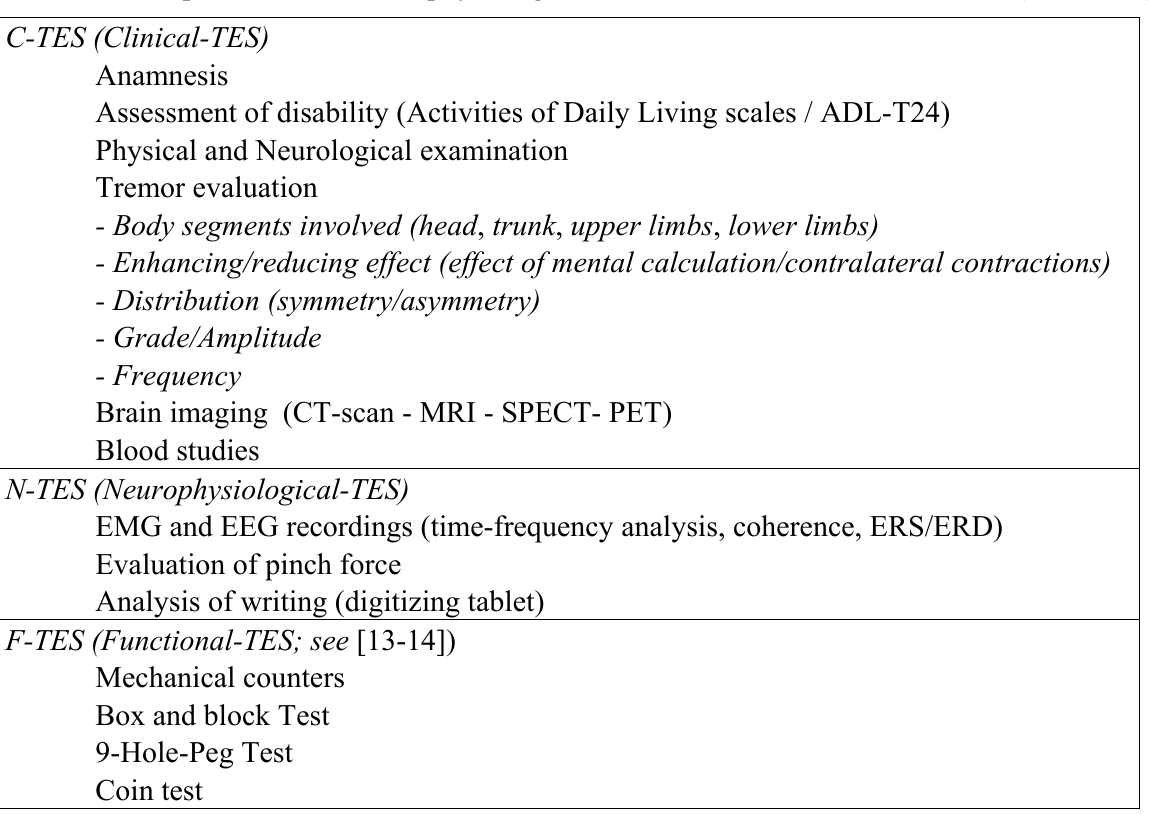
Table 2 . The composite clinical/neurophysiological/functional tremor evaluation scale (CNF-TES). C-TES (Clinical-TES)